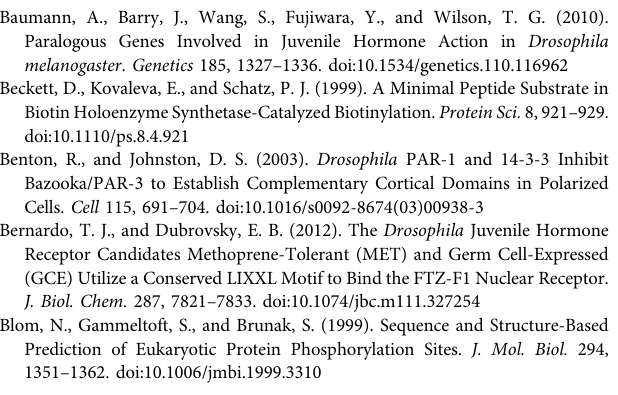
Supplementary Figure 1 | Subcellular localization ofdistinctfragments ofGce with a FLAG tag in Kc cells. (A) Scheme illustrating the full-length and truncated mutants of Gce. (B – G ’ ) Localization of truncated mutants of Gce was not altered in the absence or presence of JHA. Cells expressing truncated mutants of Gce were stained for FLAG (green). Merge images also present nuclear staining with DAPI